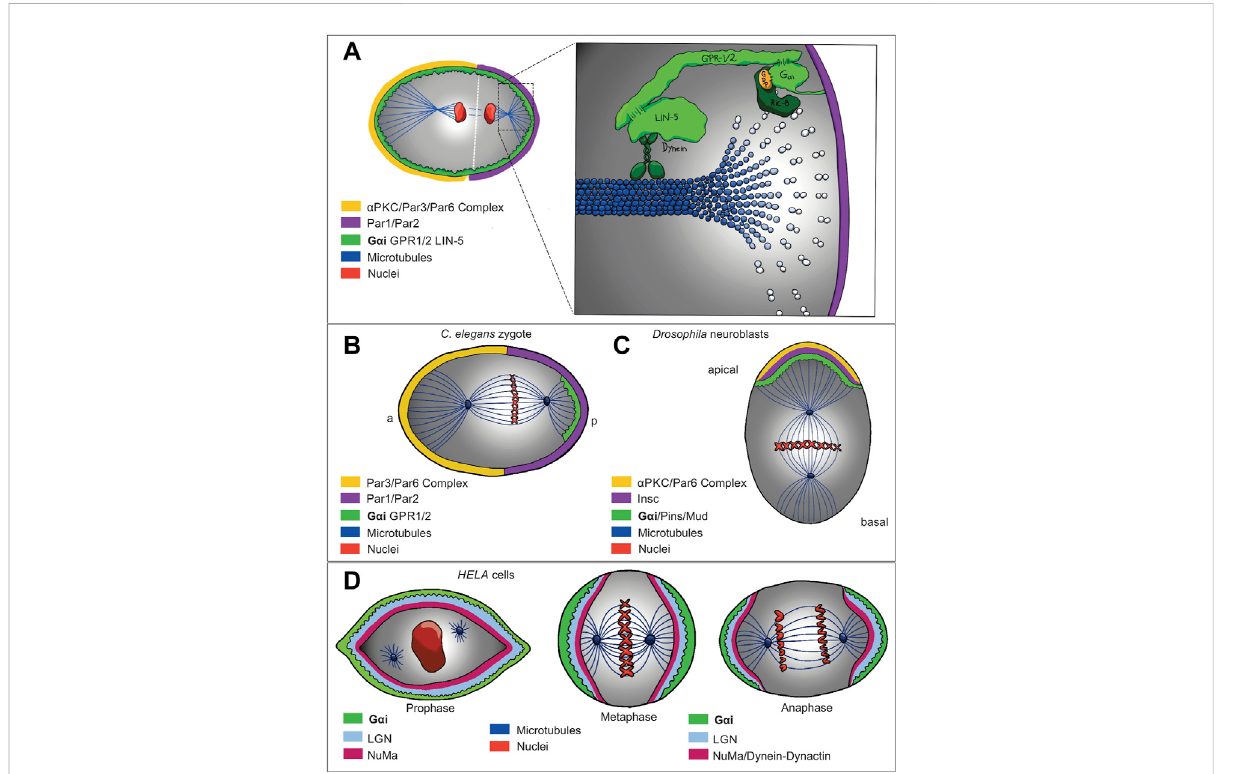
FIGURE 2 G α i non-canonical signaling network models that show regulation of asymmetric cell division (A) in (C) elegans (B) , Drosophila neuroblast (C) and HELA cells (D) . Evolutionary conservation of a molecular complex composed of the G α i subunit of the heterotrimeric G protein, LGN, dynein/ dynactin complex and NuMA (respectively G α i, Pins, and Mud in Drosophila , and GOA-1/GPA-16, GPR-1/2, and LIN5 in C. elegans ) is localized at subcortical domain recruiting dynein, a motor protein, which also determines the movement along astral microtubules and generates pulling forces to orientate the spindle correctly. While Ric-8, a guanine nucleotide exchange factor, stimulates the exchange of GDP for GTP on the G α i, triggering the dissociation of the complex that later, RGS activity stimulatethe hydrolysis of GTP on G α i,resulting in the G α i-GDP reforming the G α i- GDP/GPR-1/2 complex. On the other hand, Ric-8 as a scaffold protein, is required to localize G α i and GPR-1/2 at the plasma